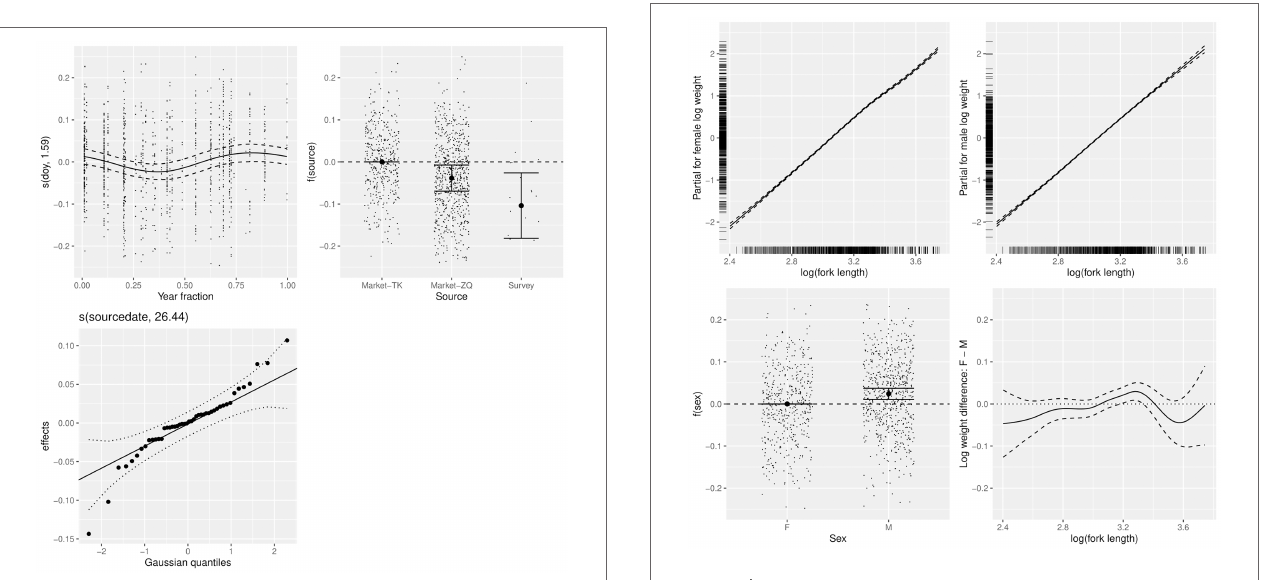
FIGURE 3 | Factors affecting the relationship between log(length) and log(weight), including the month (top left), the source of the samples (top right), and a random effect for source-date (bottom left).